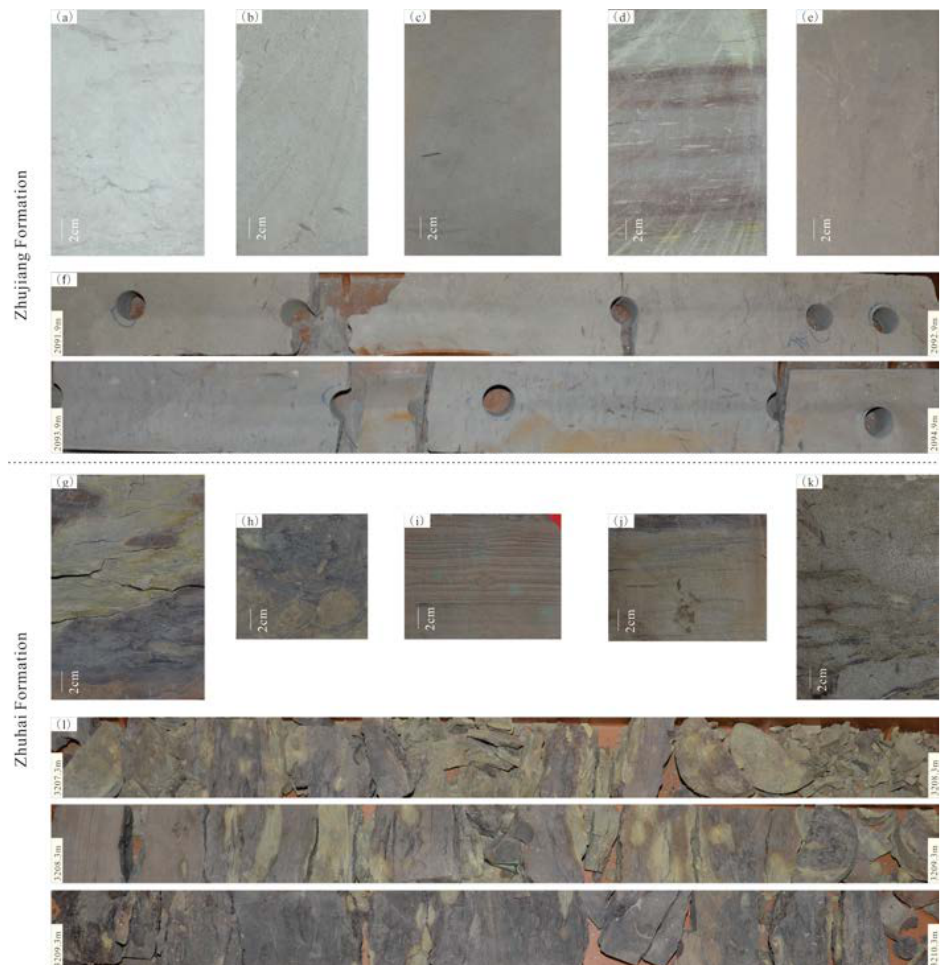
Figure 5. Typical sedimentary characteristics of the deposits in the Zhujiang ( a – f ) and Zhuhai ( g – l ) Formations in the Zhu III Depression: ( a ) 2092.5 m in Well W4, siltstone; ( b ) 2092.8 m in Well W4, siltstone; ( c ) 2090.2 m in Well W4, fine-grained sandstone; ( d ) 2091.3 m in Well W4, fine-grained sandstone and siltstone with parallel bedding; ( e ) 1220.3 m in Well W32, fine-grained sandstone with normally graded bedding; ( f ) 2.0 m (2091.9–2092.9 m and 2093.9–2094.9 m) long core of the